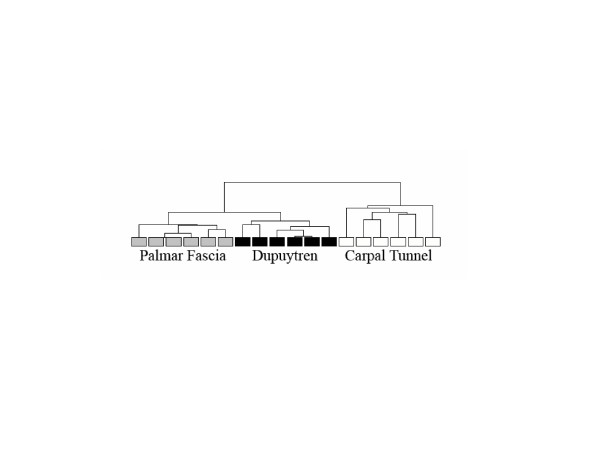
Unsupervised Hierarchical Clustering of Expression Values Based on Sample Origin. The sample distributions of significantly different transcripts (959 transcripts, SAM v. 3.02) are displayed based on unsupervised, hierarchical, agglomerative clustering (Partek: v. 6.4) of log base 2 intensity values. A primary branch of the dendrogram distinguishes the expression values obtained from transcripts of the palmar fascia- and Dupuytren's-derived fibroblasts from those of the carpal tunnel-derived fibroblasts, indicating a distinct difference based on these tissues of origin. Dupuytren's and palmar fascia-derived fibroblasts also formed distinct clusters separate from each other at the next branching level despite their matched patient origin